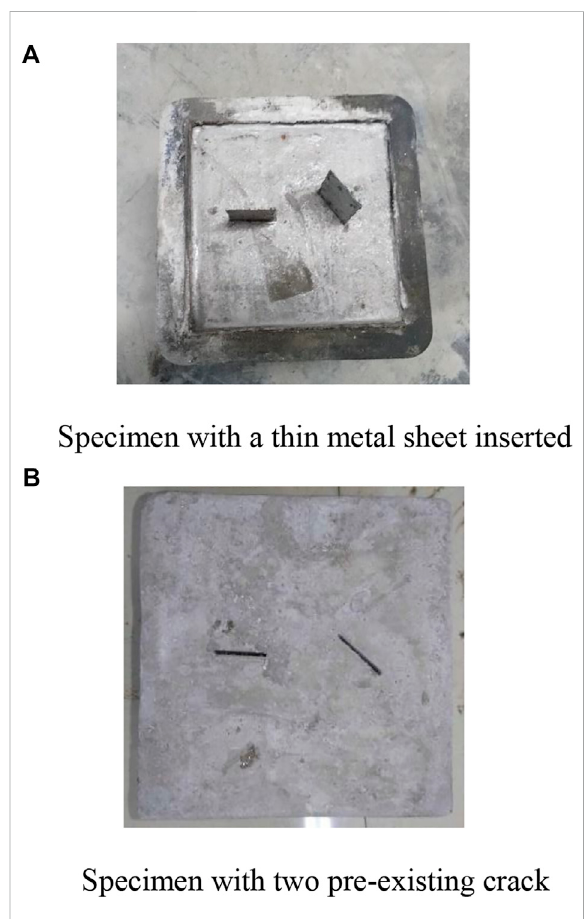
FIGURE 2 Specimen preparation. (A) Specimen with a thin metal sheet inserted, (B) Specimen with two pre-existing crack.